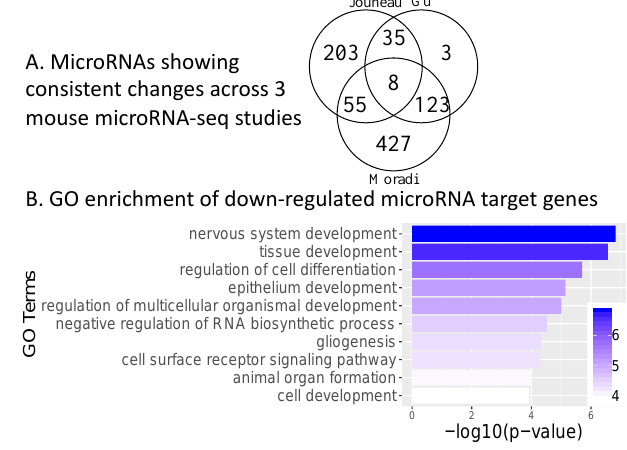
Figure 4. microRNAs regulating mouse naïve to primed ESCs transition: ( A ) Venn diagram of microRNAs changing in the same direction in naïve to primed transition across three microRNA-seq studies of mouse ESC vs. mouse EpiSC. ( B ) Gene ontology enrichment of microRNA target genes with lower expression in mouse ESCs (the microRNA regulators are higher in naïve). The x-axis is the negative log10 of enrichment p -value (larger means more significant).